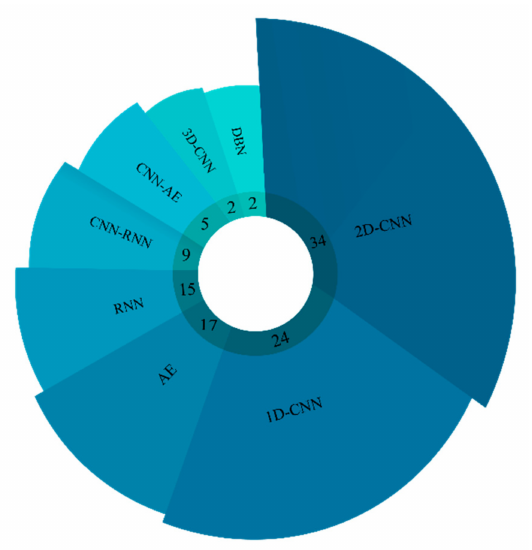
Figure 2. Number of studies conducted using various DL models from 2014 until now